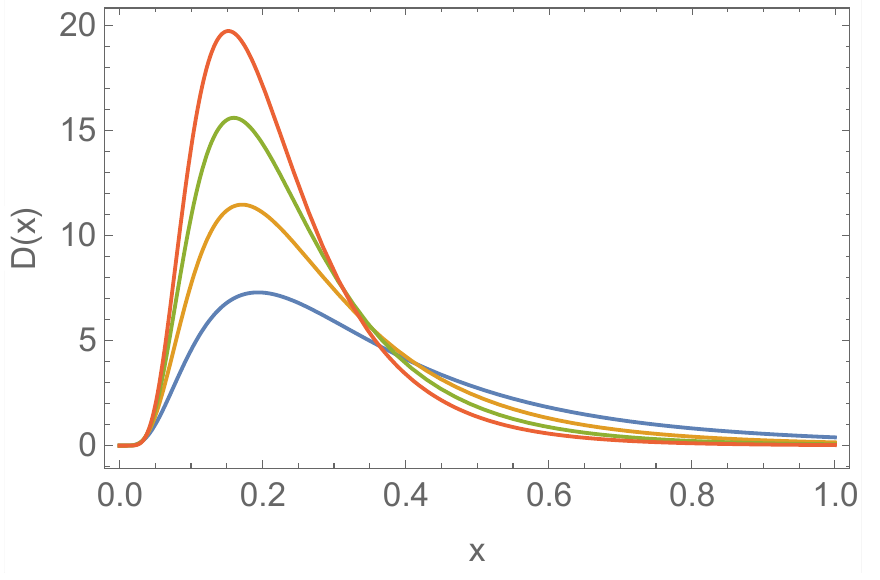
Figure 3 . Fragmentation function as a function of the energy fraction x for various energies. From bottom to top: 300 GeV, 500 GeV, 700 GeV and 900 GeV. Here we (cid:12)x the matching value as x M = 0 : 1, and used M ~ = 15 G